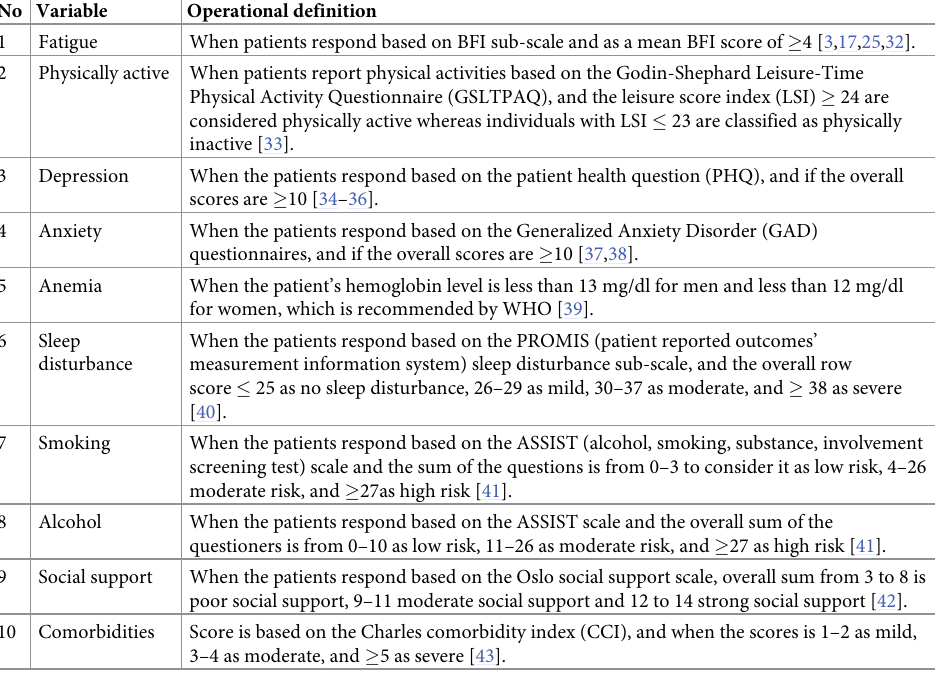
Table 2. Operational definition for fatigue and associated factors among adult cancer patients receiving cancer treatment at oncology unit in Amhara region, Ethiopia,